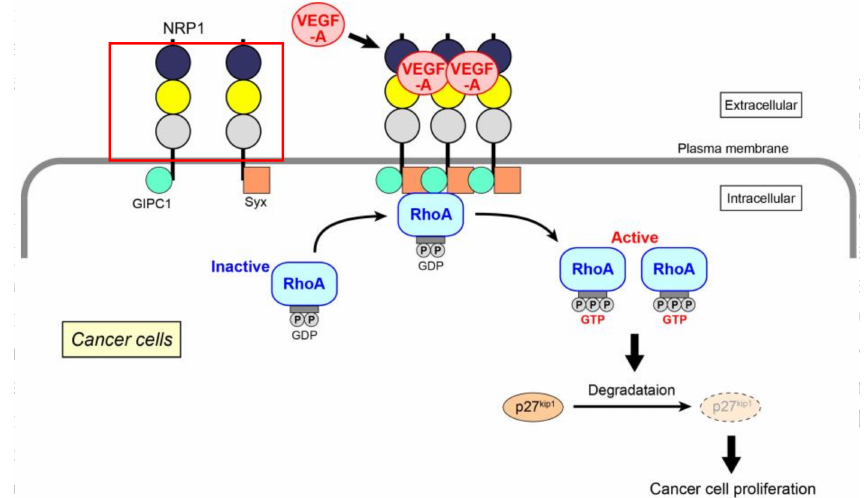
Figure 1. VEGF-A-initiated RhoA activation through NRP1 for cancer cell proliferation. After the binding of VEGF-A to NRP1, assembly of NRP1 occurs, resulting in increased GIPC1–Syx complex formation. RhoA is activated by Syx, a GEF for RhoA. Degradation of p27 kip1 by activated RhoA contributes to the proliferation of cancer